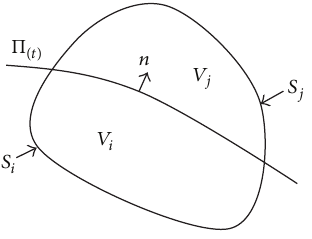
Figure 1: Kinematic state of shock wave